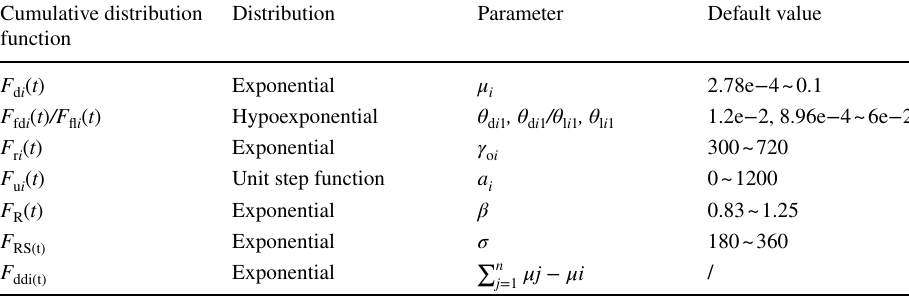
Cumulative distribution